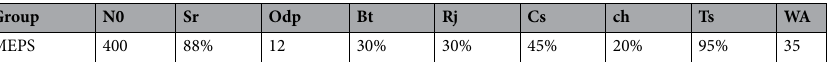
Table 4. Different radiological findings in MEPS study group. Sr Subperiosteal resorption, Odp Osteolysis of distal phalanges, Bt Brown tumours, Rj Rugger jersey appearance of vertebral column, Cs Calcaneal spurs, ch chondrocalcinosis, Ts Tuft spur-like excrescences, WA wrist